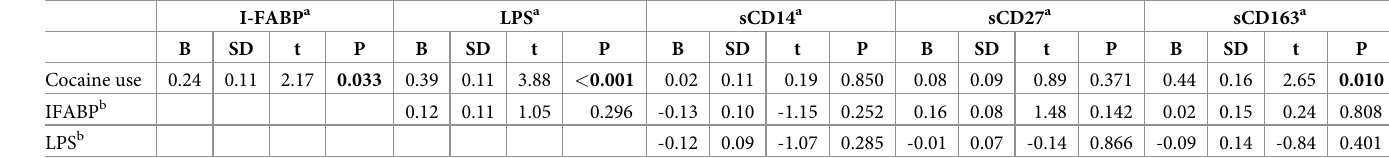
Table 3. Associations between cocaine use, gut integrity damage, microbial translocation and immune